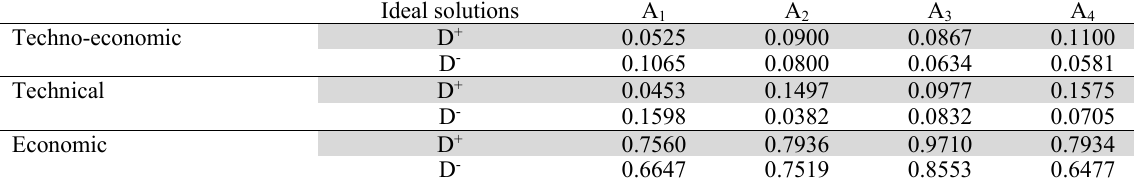
Distances from the positive and negative ideal solutions Ideal solutions